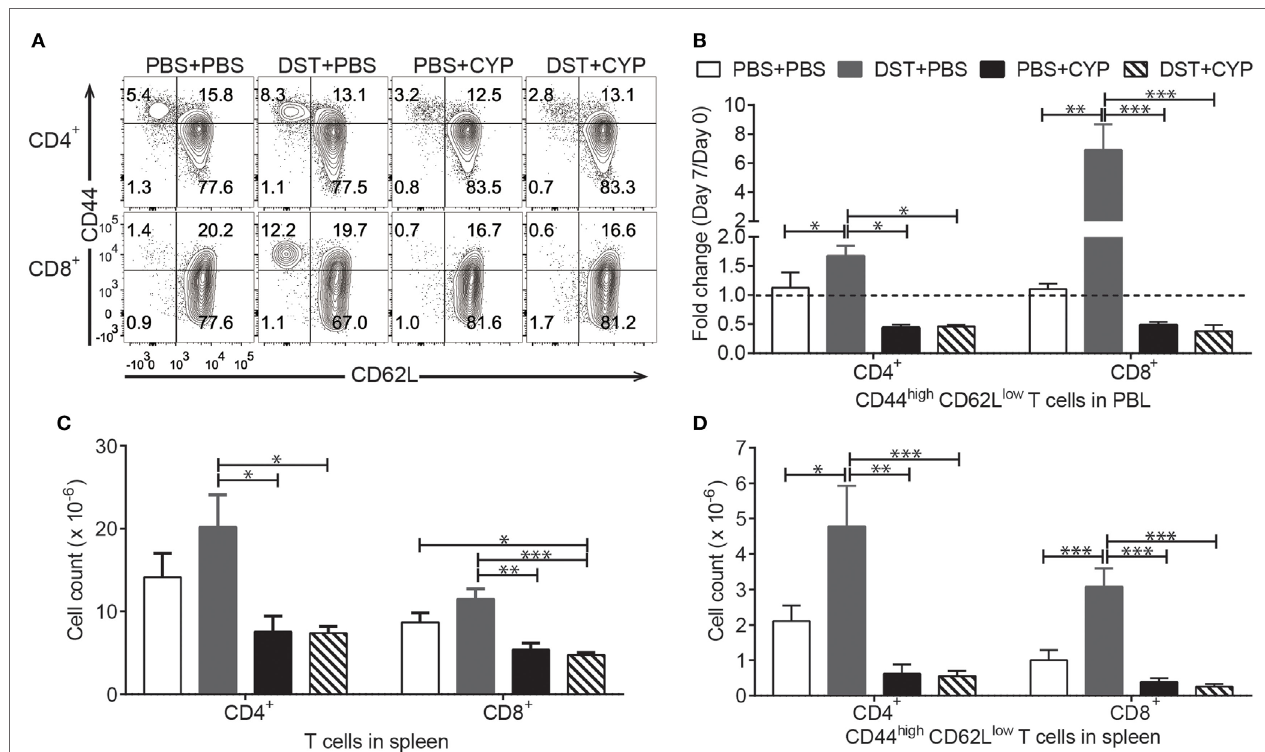
FigUre 1 | Donor-specific transfusion (DST)-cyclophosphamide (CYP) is effective in autoimmune recipients. Naive female non-obese diabetic (NOD) mice were given 20 × 10 6 C3H splenocytes or vehicle [phosphate-buffered saline (PBS)] intraperitoneal (i.p.) on day 0 and a dose of CYP, or vehicle i.p. on day 2. Peripheral blood lymphocytes (PBL) were taken on day 0 and day 7 for analysis. All mice were euthanized on day 7 and splenocytes were harvested for analysis. (a) Representative analysis of PBL on day 7, CD4 + TCR β + gate for the upper panel and CD8 + TCR β + gate for the bottom panel. (B) Shown is fold change of CD44 high CD62L low cells in CD4 + TCR β + gate (left) and CD8 + TCR β + gate (right) on day 7 compared to day 0 (mean ± SEM). (c) Shown are absolute numbers of CD4 T cells (left) and CD8 T cells (right) in the spleen on day 7 (mean ± SEM). (D) Shown are absolute numbers of CD44 high CD62L low CD4 T cells (left) and CD44 high CD62L low CD8 T cells (right) in the spleen on day 7 (mean ± SEM). Data were pooled from four independent experiments (four to six mice per group). * p < 0.05, ** p < 0.005, *** p < 0.001, one-way ANOVA with Tukey’s multiple comparison